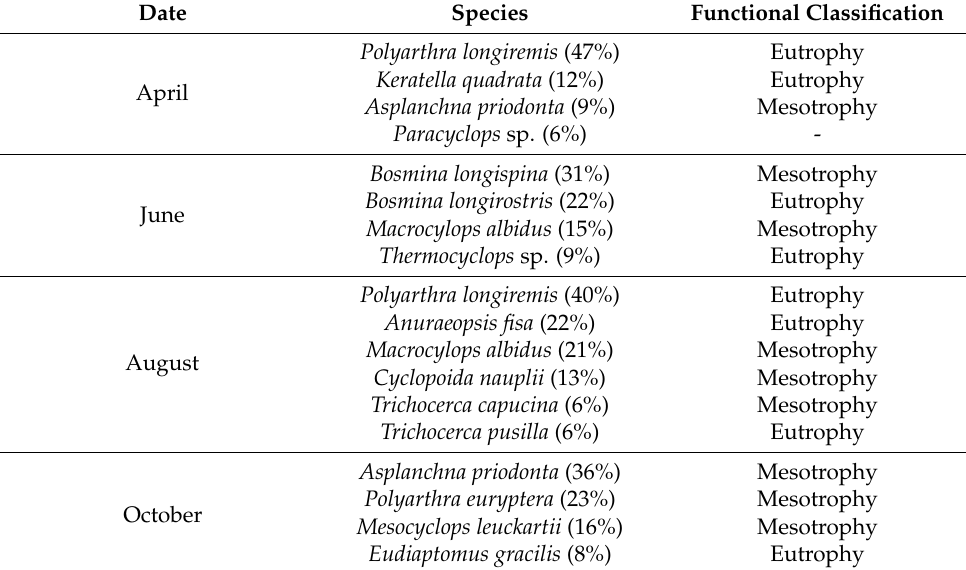
Figure 3. Zooplankton density ( A ) and biomass ( B ) in Lake Sztynorckie (representative site in profundal zone, S1) with an emphasis on each taxonomic group. Table 2. Dominant species ( ≥ 5% of total biomass) in zooplankton of Lake Sztynorckie during the whole growing season of